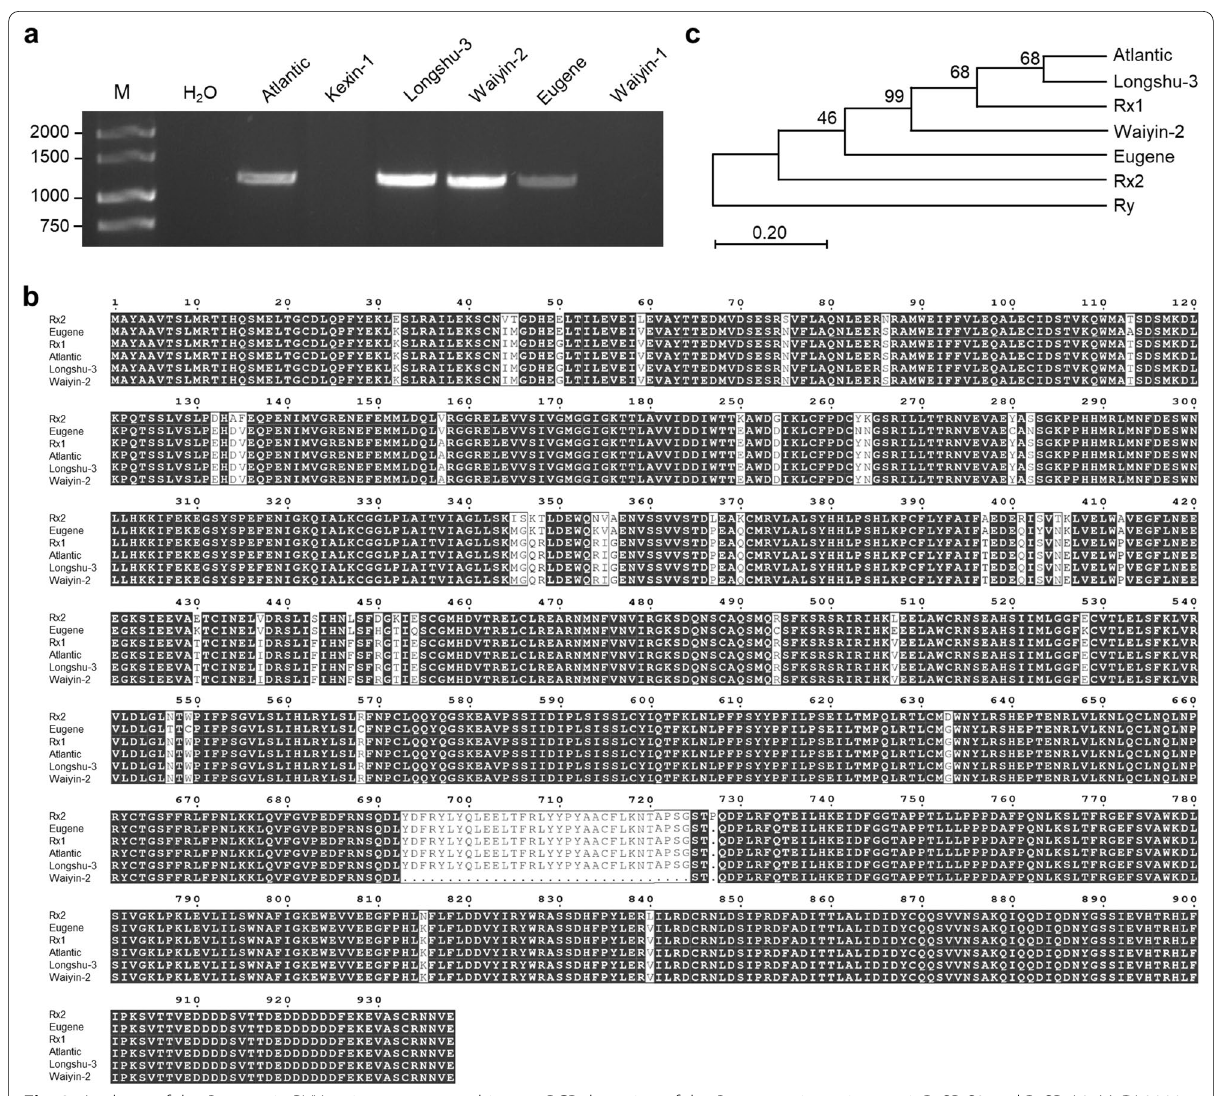
Fig. 3 Analyses of the Rx gene in PVX-resistant potato cultivars. a PCR detection of the Rx gene using primer pair RxSP-S3 and RxSP-A2. M, DL2000 DNA marker (Vazyme). b Multiple sequence alignment of the amino acid sequences of Rx1, Rx2 and their paralogs from Longshu-3, Eugene, Atlantic and Waiyin-2. The conserved identical amino acids are highlighted in black. Sequences were aligned with Clustal Omega and displayed by ESPript 3.0. c Phylogenetic analysis of Rx1 and its paralogs. The phylogenetic tree was constructed using the Maximum Likelihood method with 1000 bootstrap replicates and rooted to Ry (Genbank accession no.